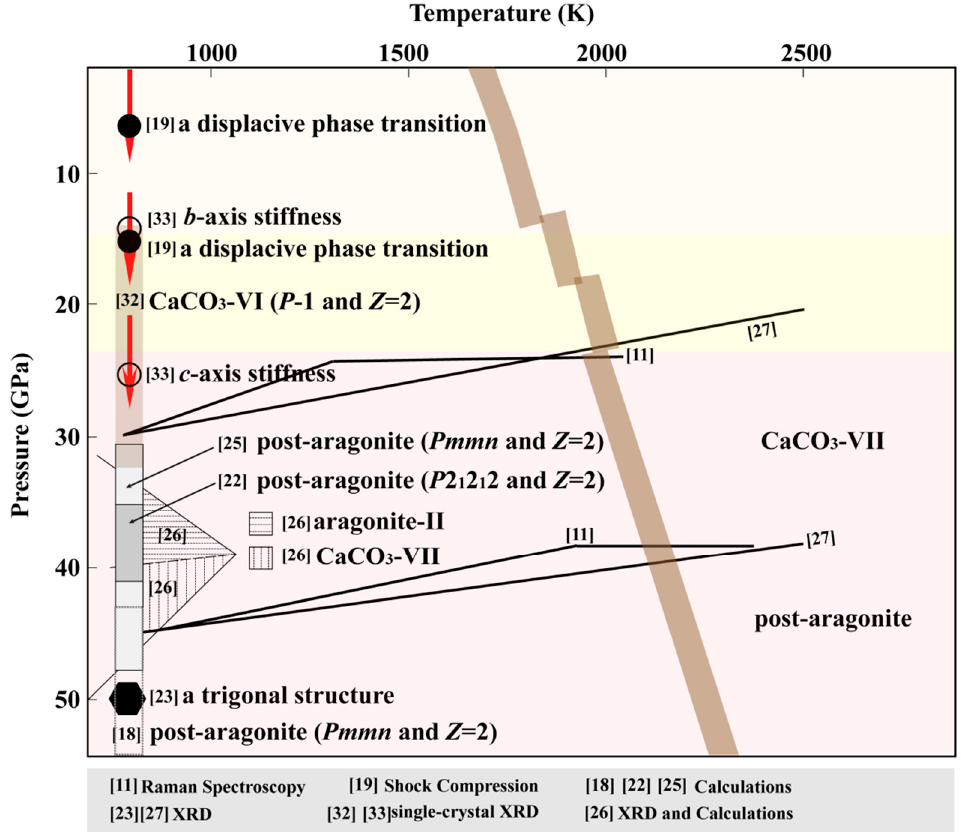
Figure 1. Phase diagram of CaCO 3 under mantle conditions. The solid black lines depict the phase boundaries as labeled. Two studies using single-crystal specimen of aragonite have detected a phase transition or a reduction in the b -axis compressibility at ~15 GPa, respectively. The light gray zone indicates the mantle geotherm [34]. The dotted arrow represents the experimental conditions presently.